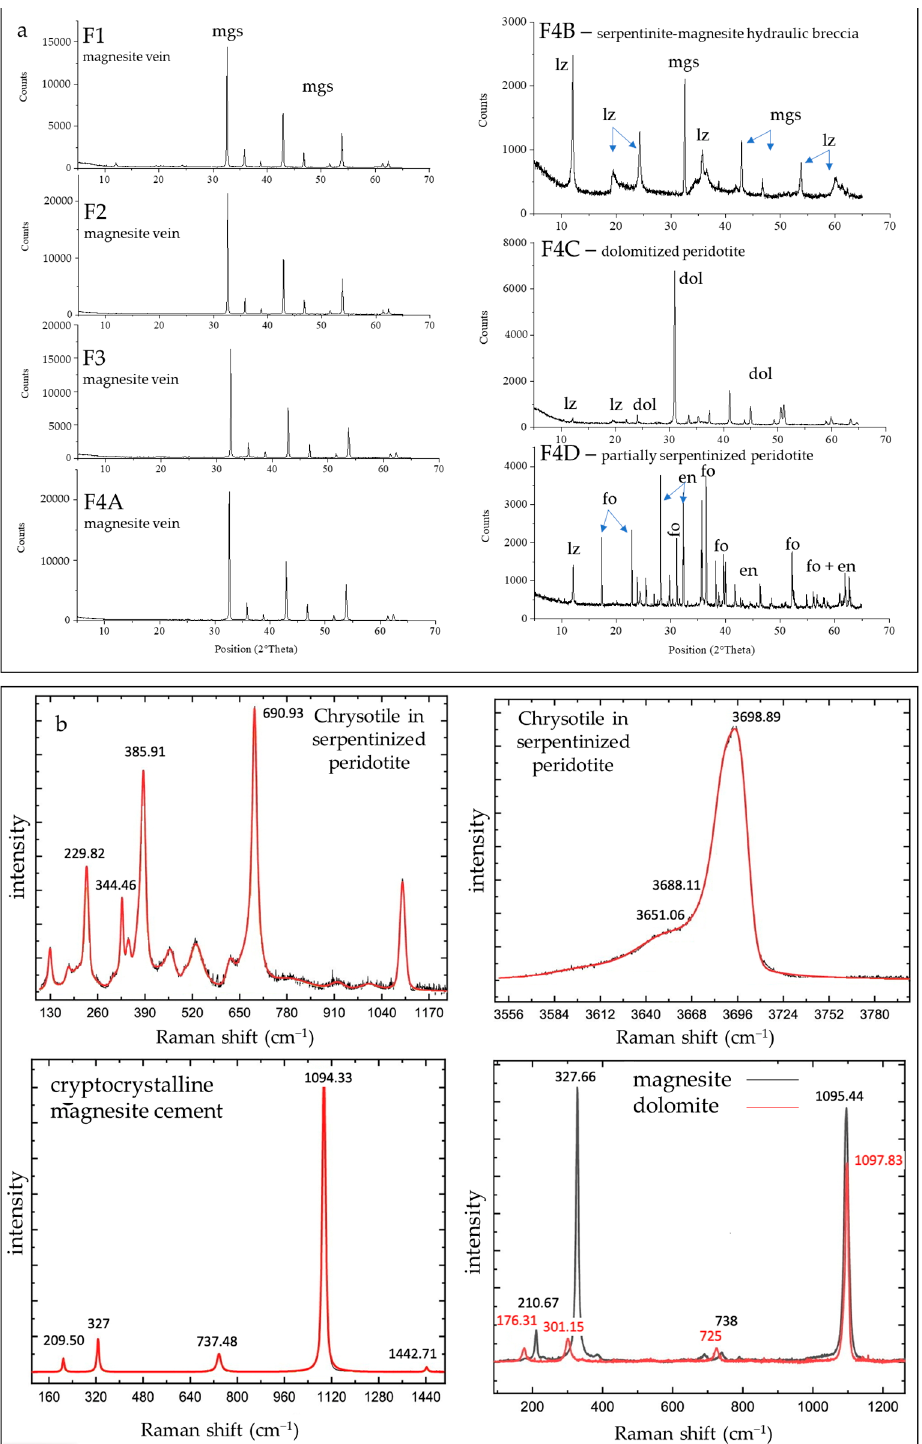
Figure 7. ( a ) XRPD pattern of magnesite samples (F1, F2, F3, F4a), serpentinite–magnesite hydraulic breccia (F4b), dolomitized peridotite (F4c), and partially serpentinized peridotite (F4d). Mgs: magnesite, lz: lizardite, dol: dolomite, fo: forsterite, en: enstatite. ( b ) Selected µ -Raman spectra of: chrysotile within a submillimetric veinlet in a partially serpentinized peridotite for the spectral region 110.86–1097.14 cm − 1 ( upper left ) and for the spectral region 3599.53–3698.89 cm − 1 ( upper right ); magnesite with massive cryptocrystalline texture within the cement of serpentinite–magnesite hy- draulic breccia ( lower left ); magnesite and dolomite with microcrystalline polygonal texture within the cement of serpentinite–magnesite hydraulic breccia ( lower right